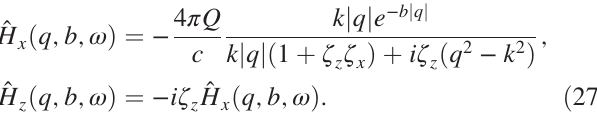
¼ ð u þ u Þ =u =u as a h w hz hx w